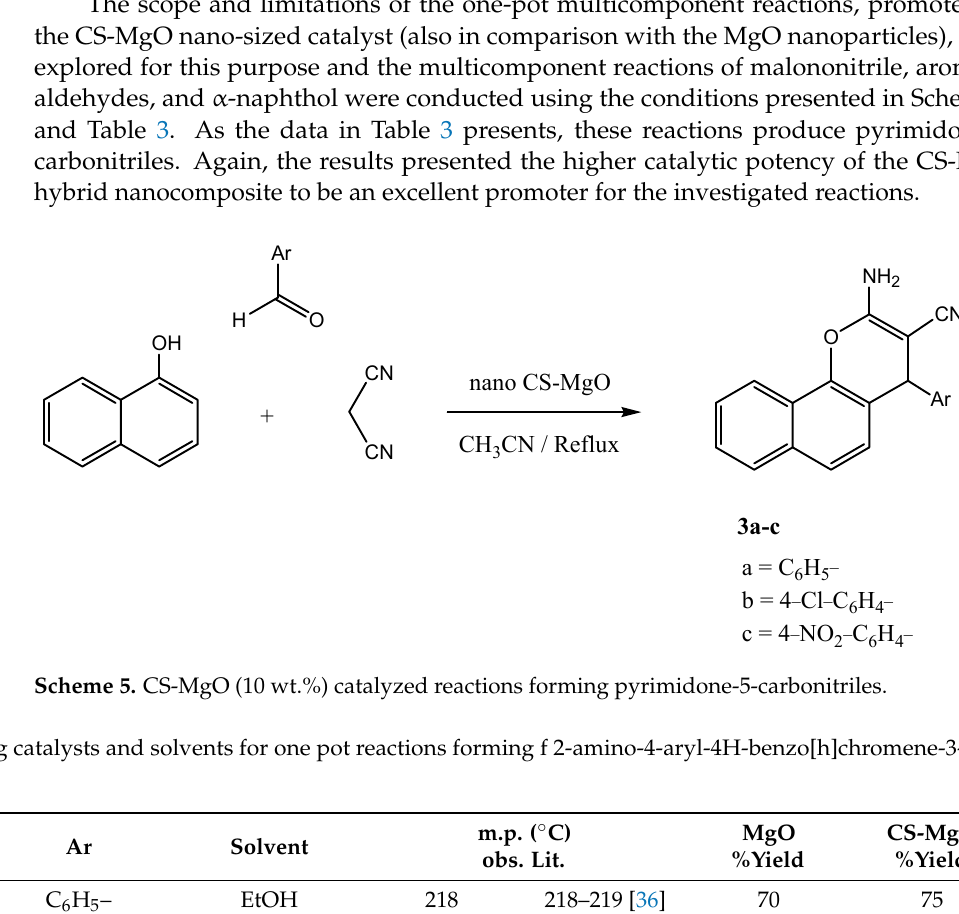
Table 3. Data comparing catalysts and solvents for one pot reactions forming f 2-amino-4-aryl-4H-benzo[h]chromene-3- carbonitrile (Scheme 5).